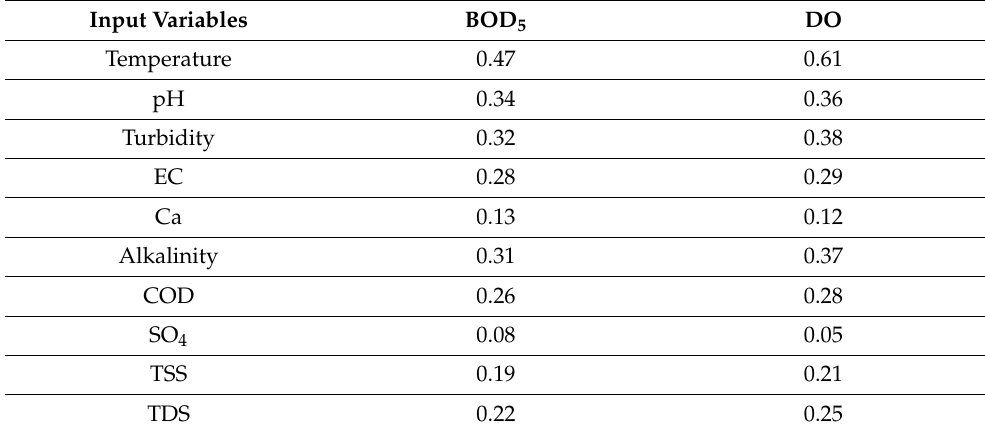
Table 2. The correlation magnitude between each WQ variable and BOD 5 and DO.